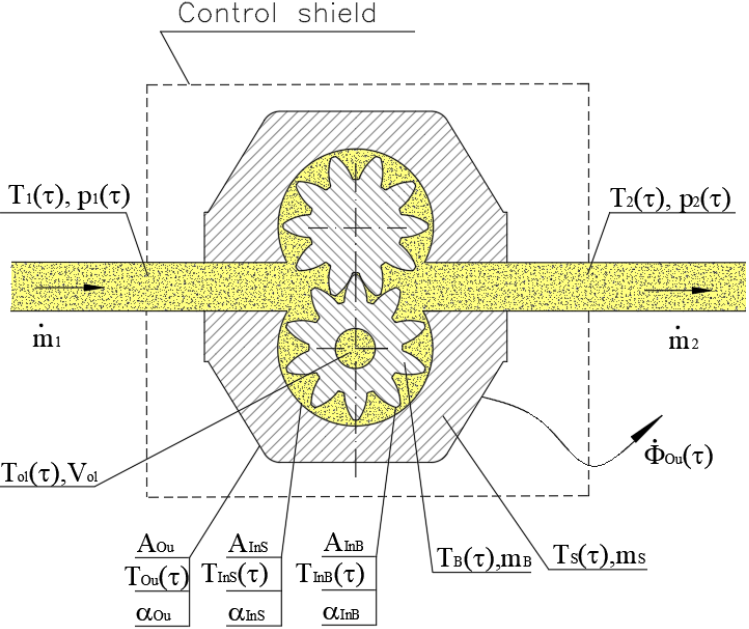
Figure 4. Model of heating of a cooled hydraulic motor by flowing hot fluid (division into movable ( B ) and fixed ( S ) motor parts); all denotations are the same as in Figure 3 above.